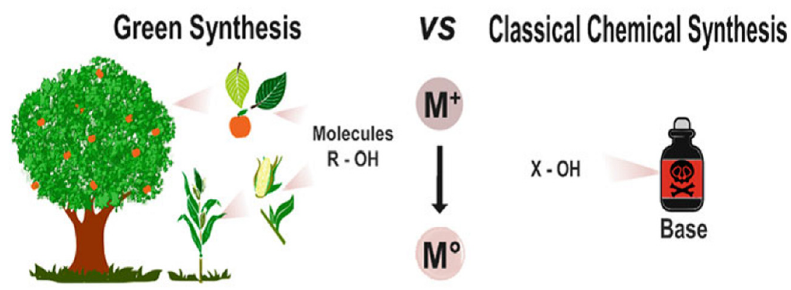
Figure 5: Schematic explanation of the two main approaches used for the synthesis of MNPs and MONPs: green and chemical ( classical ) synthesis. Dicotyledons and monocotyledons are used as the reducing and stabilizing agents in the metal salt reduction for the green synthesis of MNPs and MONPs [ 41 ]